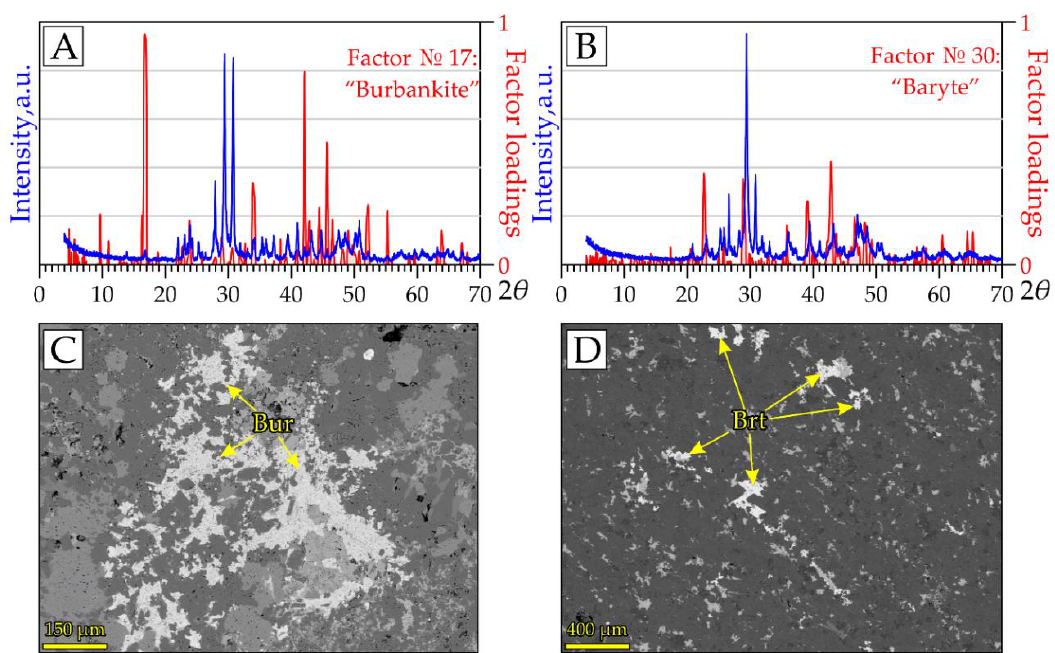
Figure 12. Comparison of the FL graphs (red lines) of ( А ) burbankite, factor #17, and ( B ) baryte, factor #30, with diffraction patterns of the samples showing the maximum FS s of the corresponding factors (blue lines). ( C ) Burbankite (Bur) and ( D ) baryte (Btr) in the same samples in BSE photos.